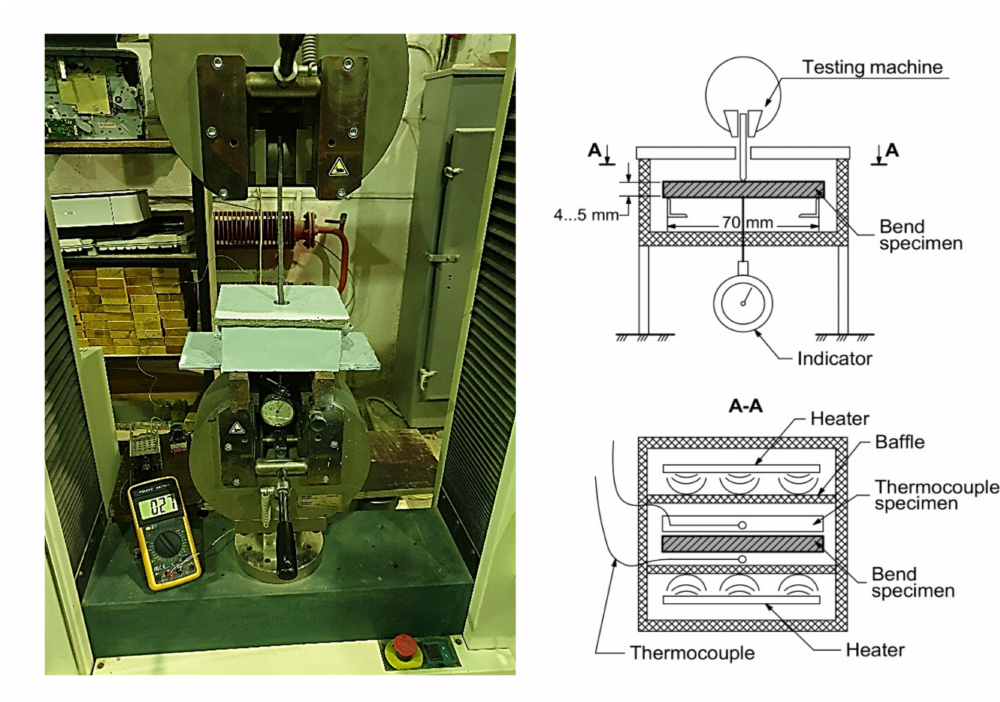
Figure 3. The three-point bending test rig.